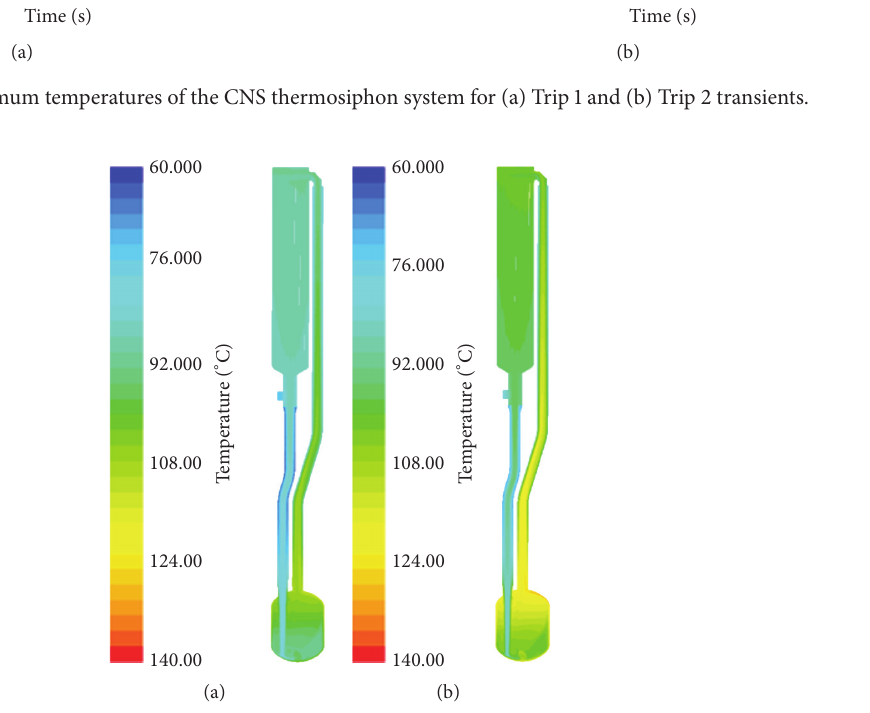
Figure 8: Predicted increased temperatures within the CNS thermosiphon system at 10 minutes after reactor shutdown for (a) Trip 1 and (b) Trip